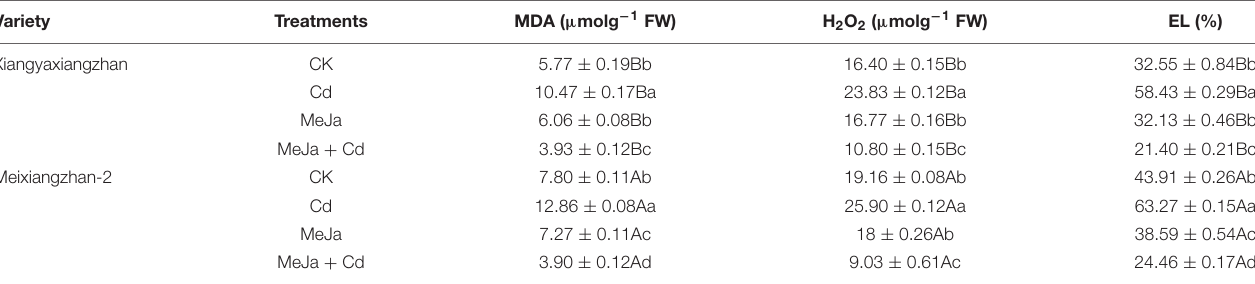
The values are representative of three replicated means per treatment ± SE. Different letters indicate significant differences between cultivars and treatments at p < 0.05, LSD. CK, control (normal conditions); Cd,100 mg Cd kg − 1 of soil; MeJa, exogenous application of MeJa at 20 mM; and Cd + MeJa, 100 mg Cd kg − 1 of soil + exogenous MeJa application at 20